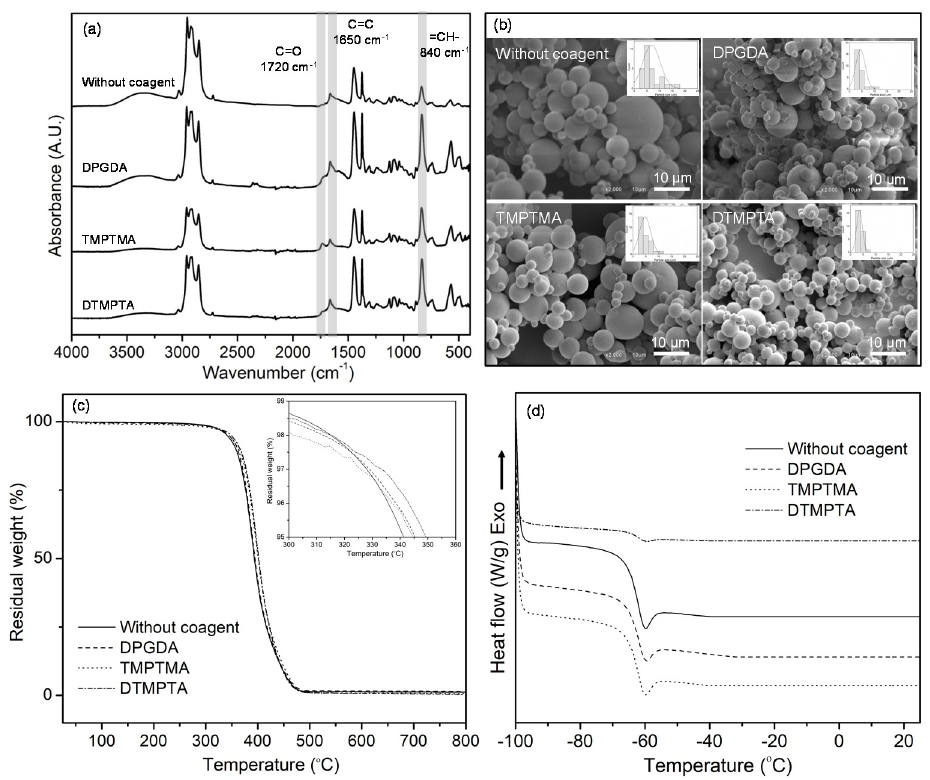
Figure 5. Infrared spectra ( a ), SEM micrographs ( b ), TGA curves ( c ), and DSC curves ( d )